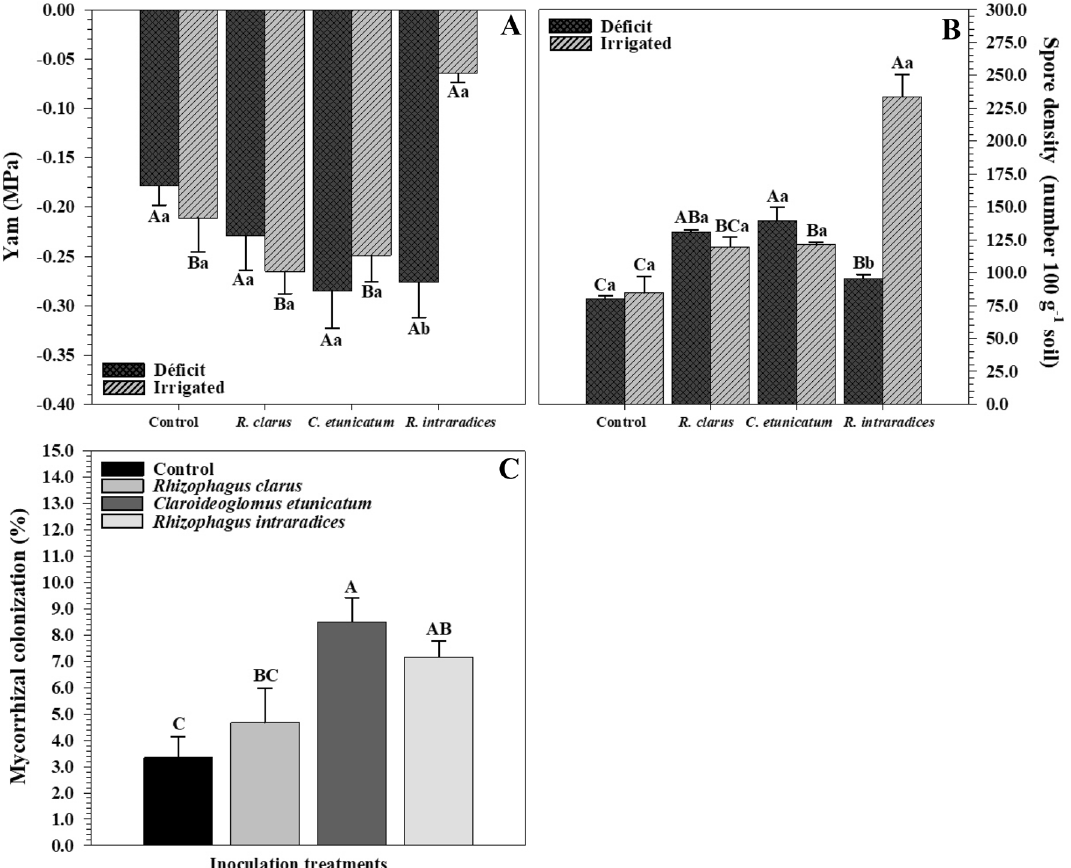
Figure 1. Water potential ( A ), spore density ( B ), and mycorrhizal colonization ( C ) of corn plants (Zea mays) submitted to different water treatments and inoculation with AMF after reirrigation. The bars represent the mean ± standard error of the mean (SEM) ( n = 4). Means followed by the same letter, uppercase among inoculation treatments and lowercase between hydric treatments, do not differ ( p > 0.05) among themselves by Tukey’s